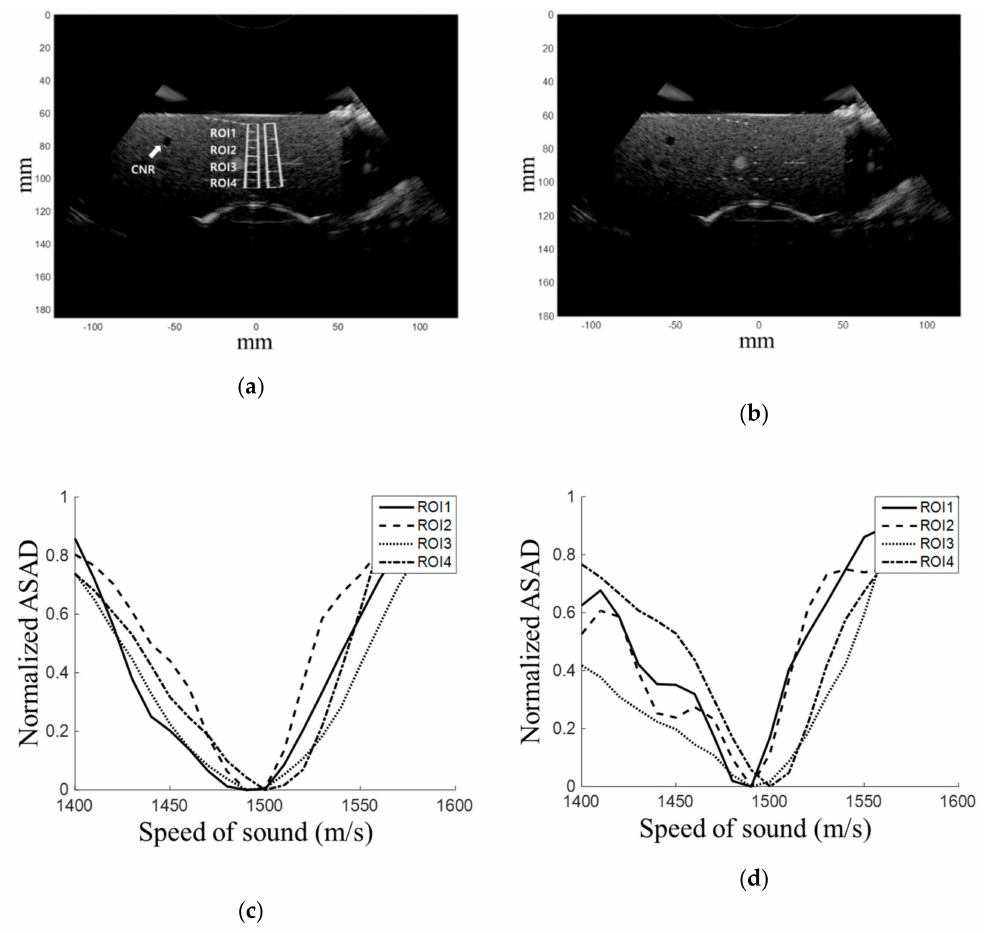
Figure 3. Experiment results of the inhomogeneous medium. B-mode image with a sound speed of ( a ) 1540 m / s and ( b ) 1490 m / s, and normalized ASAD values for ROI-1, -2, -3 and -4 for the ( c ) point target and ( d ) speckle